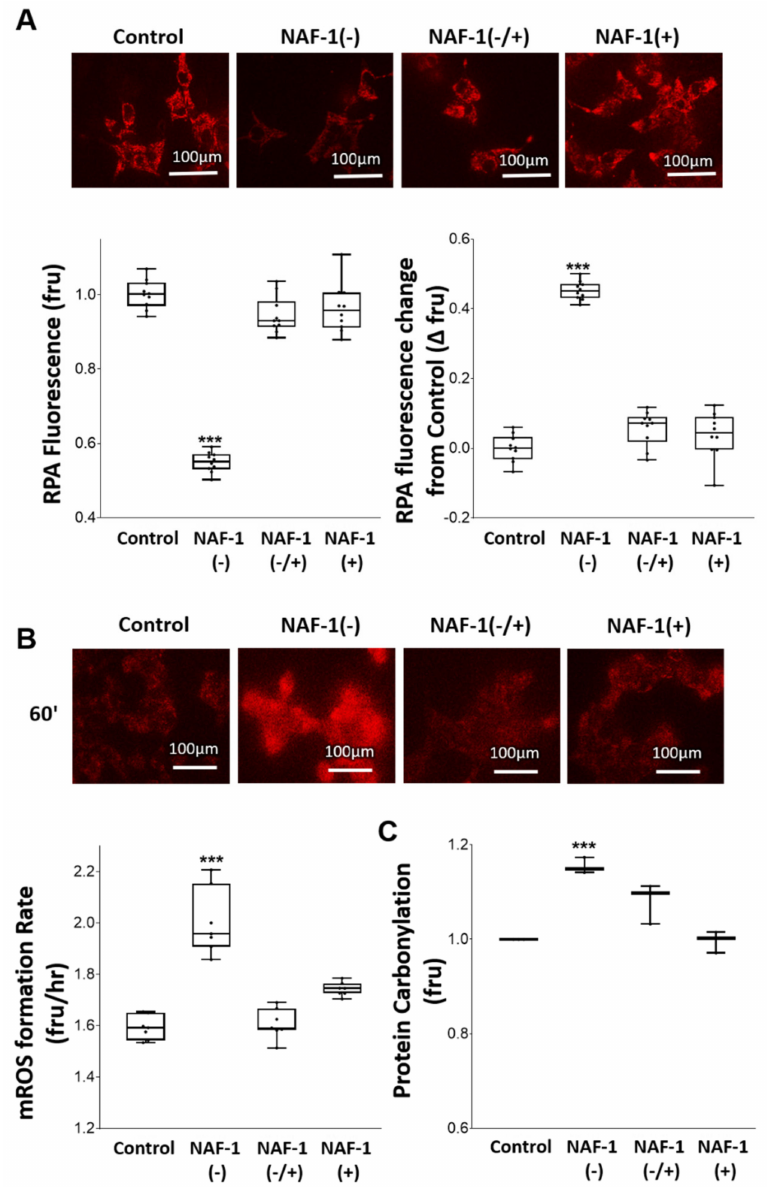
Figure 5. Mitochondrial labile iron (mLI), ROS (mROS), and protein carbonylation in INS-1E cells with repressed or overexpressed NAF-1 levels. ( A ) Representative epi-fluorescent images of mito- chondrial RPA fluorescence (top), and quantification of mitochondrial RPA fluorescence (bottom graphs) in INS-1E cells with repressed or overexpressed NAF-1 level (left graph is for total RPA fluorescence and right graph is for change in RPA fluorescence from control). Quenching of RPA fluorescence indicates mitochondrial labile iron accumulation. ( B ) Representative epi-fluorescent images of mitochondrial mito-SOX TM fluorescence (top), and quantitative analysis (bottom, left), of mitochondrial mito-SOX TM fluorescence (indicating mitochondrial superoxide accumulation), in INS-1E cells with repressed or overexpressed NAF-1 level. ( C ) Cellular content of carbonylated proteins in the different INS-1E cell lines with repressed or overexpressed NAF-1 levels, measured with coumarin hydrazine (CH). The results are presented as box-and-whisker plots and include all data points measured from three different experiments. *** p < 0.001, compared to control; Student’s t -test, N = 450 for ( A ), N = 150 for ( B ), and N = 450 for ( C